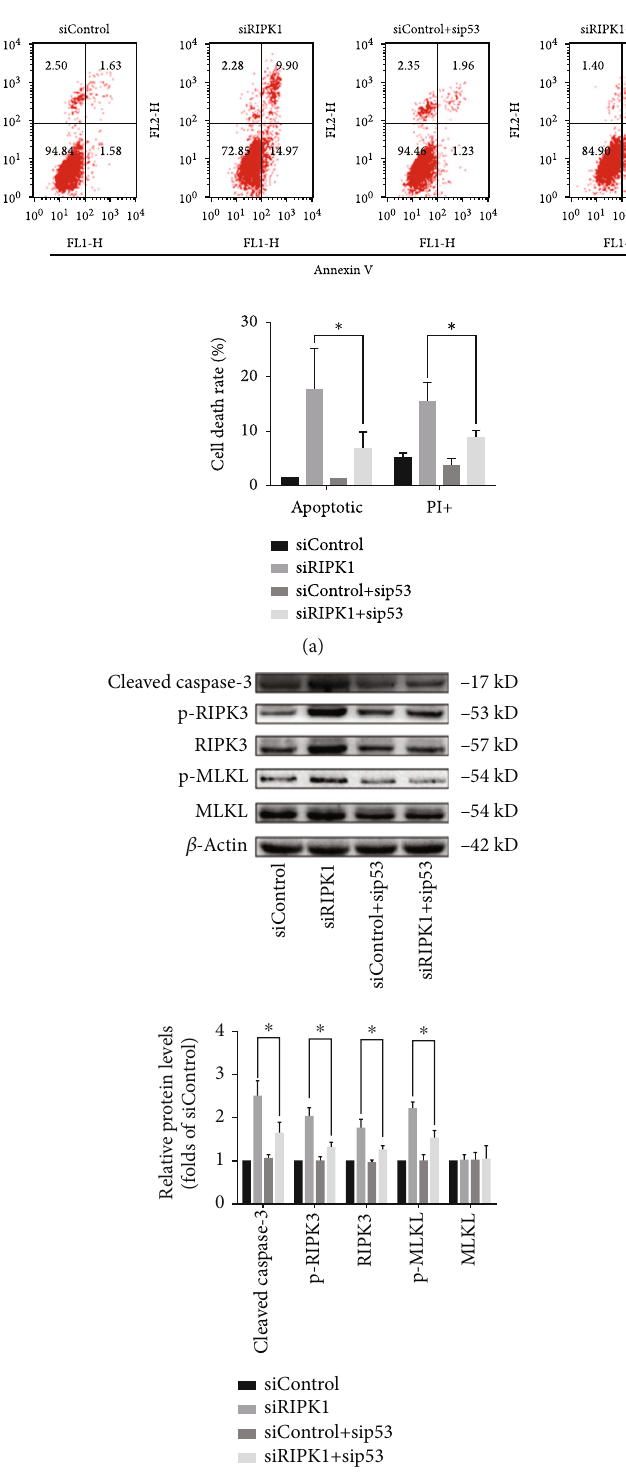
Figure 5: RIPK1 regulated cell survival of bone marrow MSCs via p53. (a) Representative graphs were analyzed using the fl ow cytometer and quanti fi cation analysis suggested that knockdown of p53 signi fi cantly reduced the apoptotic and necrotic cell death rate in RIPK1- de fi cient bone marrow MSCs. Values are expressed as the means ± SD from three independent experiments ( ∗ p < 0 : 05 , vs. siRIPK1; n = 3 ). (b) Representative western blots for the expression of Cleaved caspase-3, p-RIPK3, p-MLKL, and corresponding total protein. Histogram analysis showing the relative protein levels of Cleaved caspase-3, p-RIPK3, p-MLKL, and corresponding total protein. Data are presented as the means ± SD from three independent experiments ( ∗ p < 0 : 05 , vs. siRIPK1; n = 3